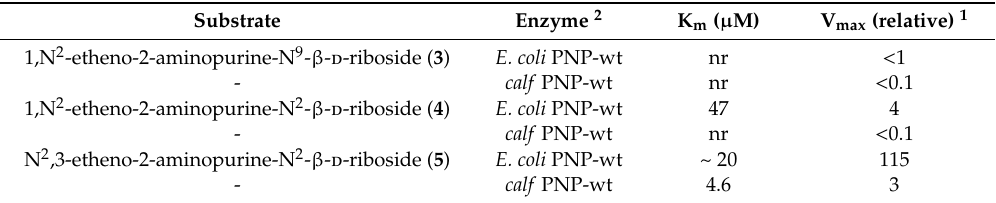
Table 4. Kinetic parameters for the enzymatic phosphorolysis of selected etheno-2-aminopurine ribosides in 40 mM phosphate bu ff er, pH 7, using various forms of PNP. Standard errors are estimated to be ~ 20%; nr = no reaction